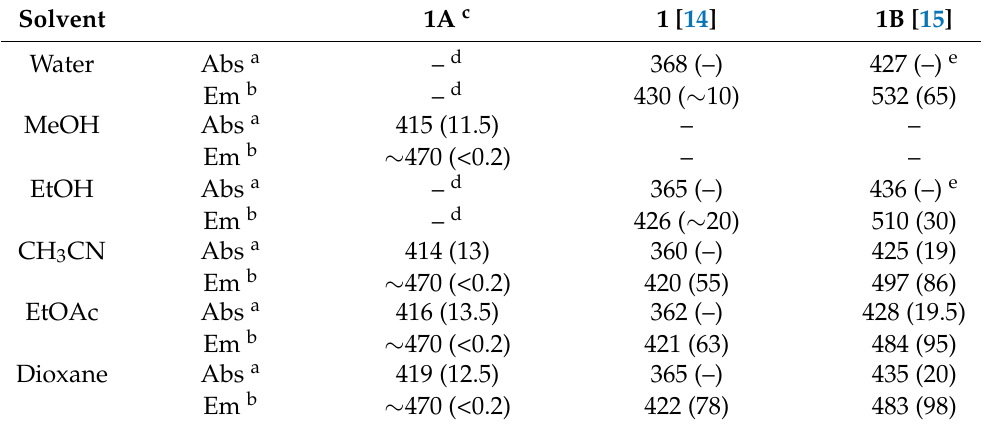
Table 1. Experimental photophysical properties of compounds 1 , 1A , and 1B in various